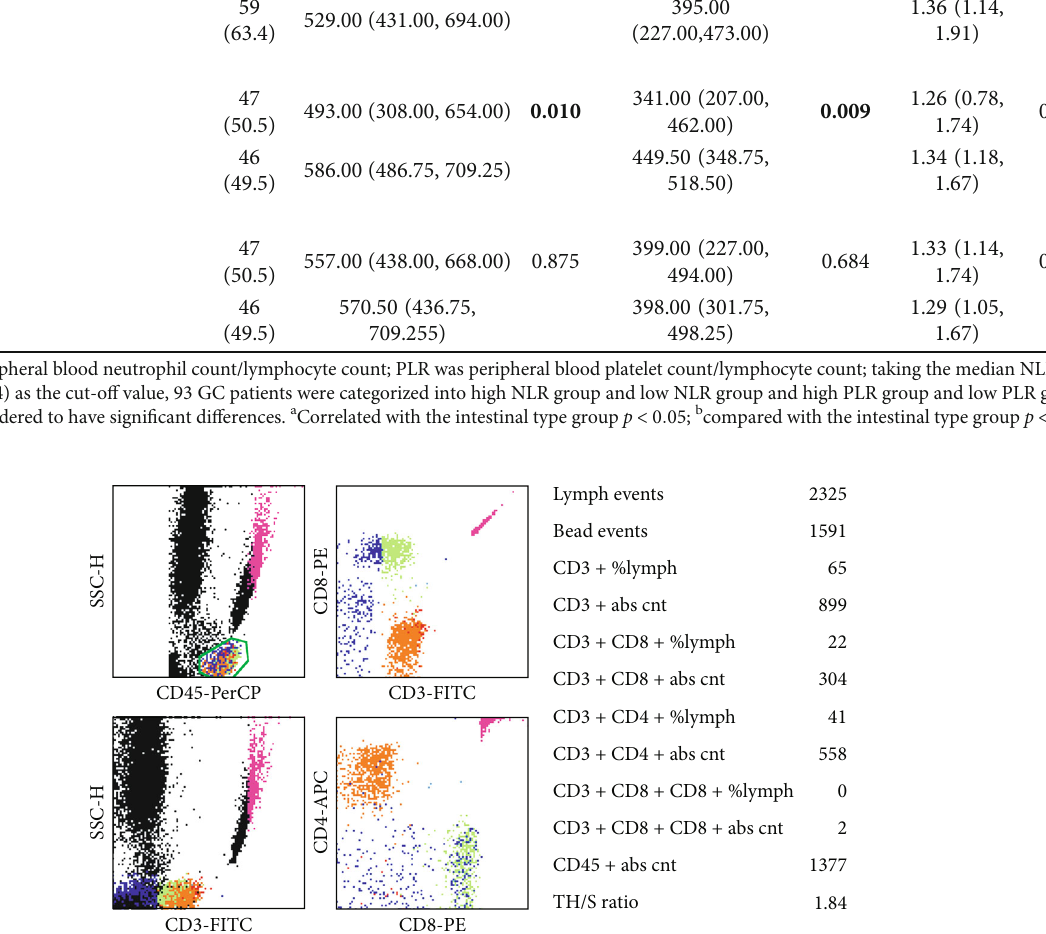
Figure 1: Four-color fl ow cytometric plots of CD3 + CD4 + T cells and CD3 + CD8 + T cells in the peripheral